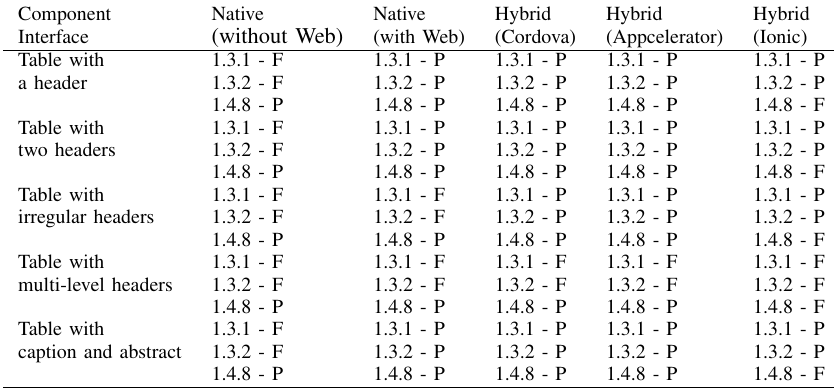
TABLE VII A CCESSIBILITY INSPECTION OF TABLE